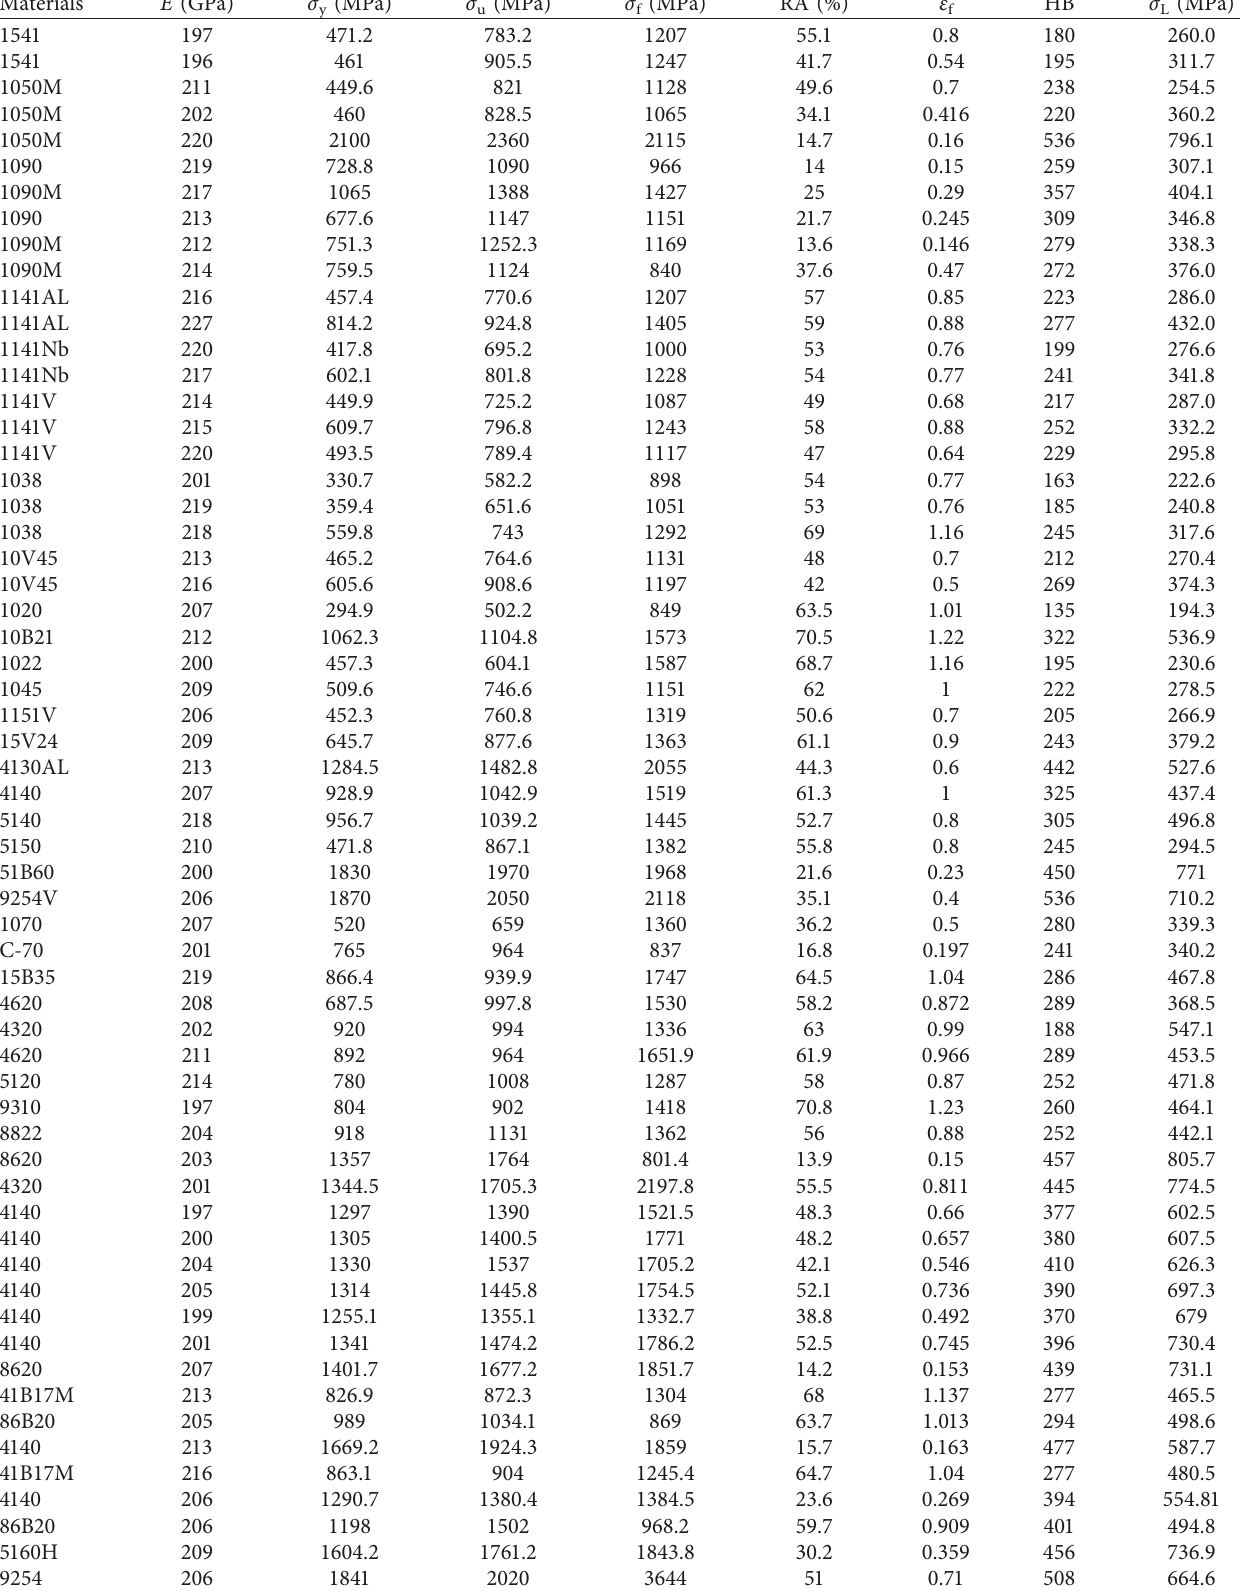
Table 1: Monotonic deformation properties and fatigue limit of the selected steels from the AISI Bar Steel Fatigue Database [6].